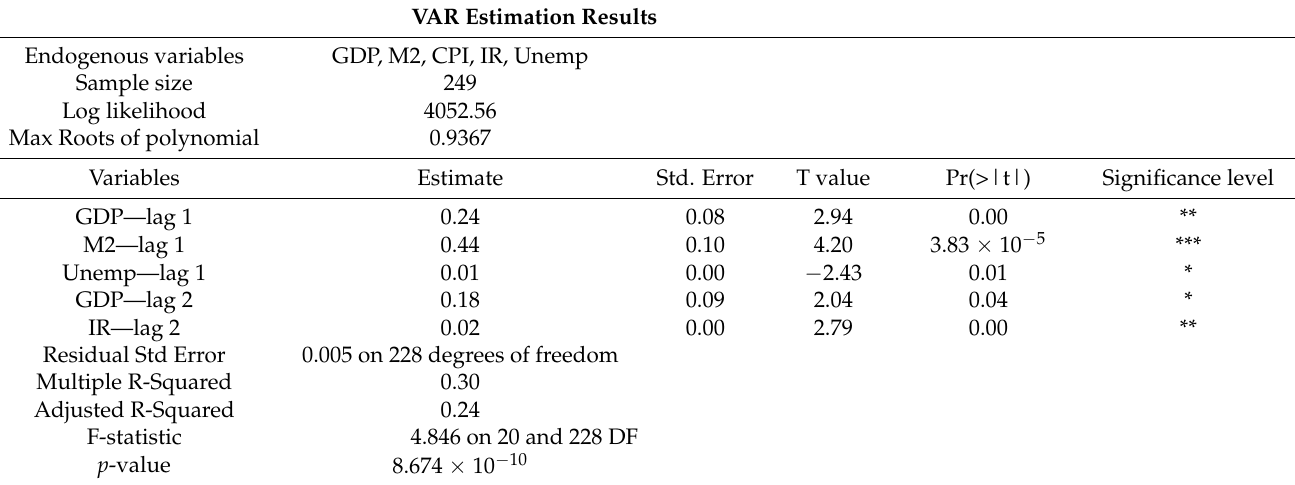
Table 5. The VAR estimation for Gross Domestic Product (GDP). VAR Estimation